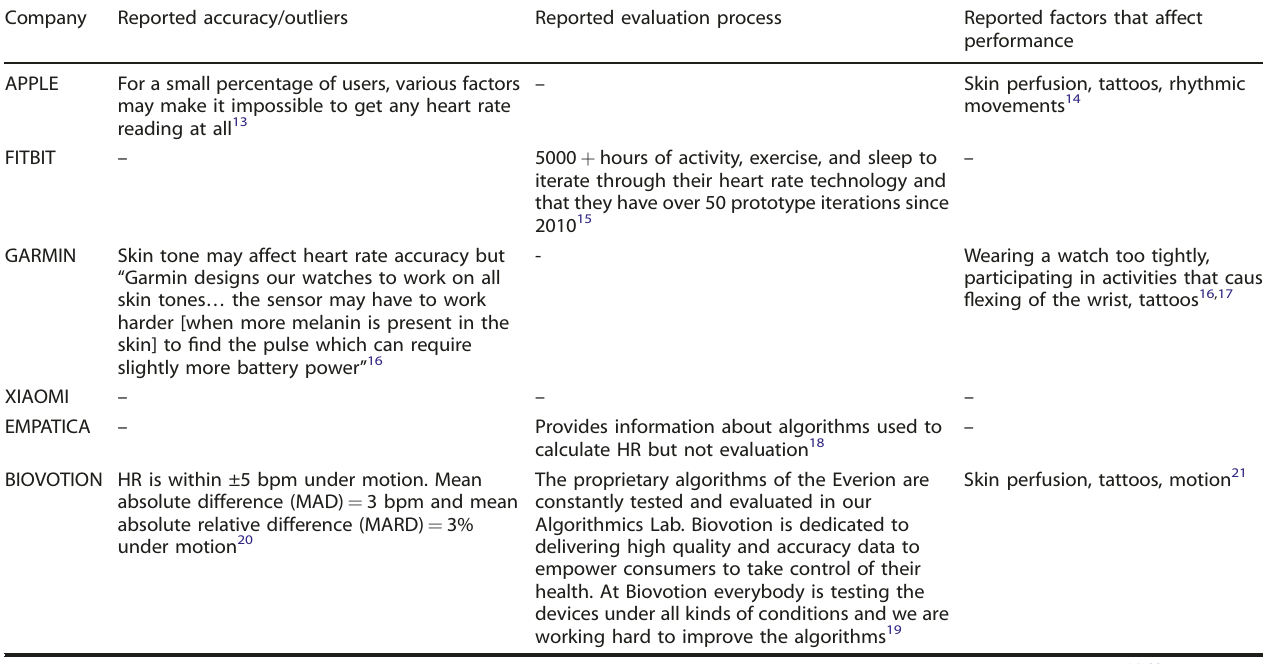
Table 1. Reported accuracy, outliers, evaluation process, and factors that affect performance by each device manufacturer.